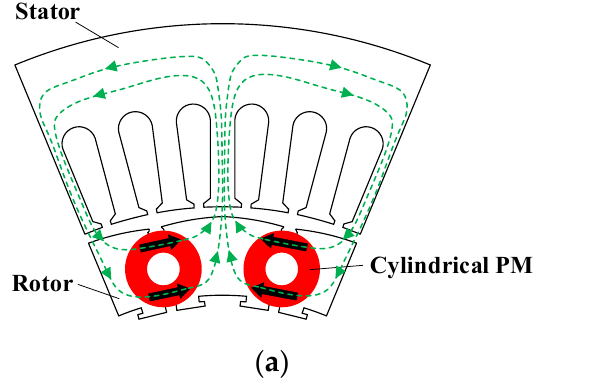
Figure 16. Illustration of operating principle of the rotor ‐ PM MR machine with cylindrical PMs [60]. ( a ) Flux ‐ enhancing state. ( b ) Flux ‐ weakening state.